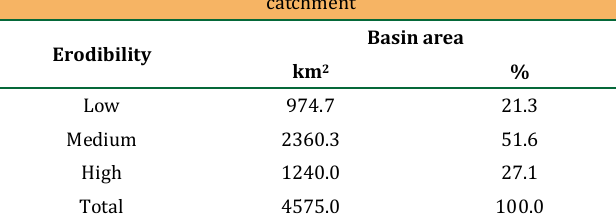
Lithology classification according to rock resistance to erosion Table